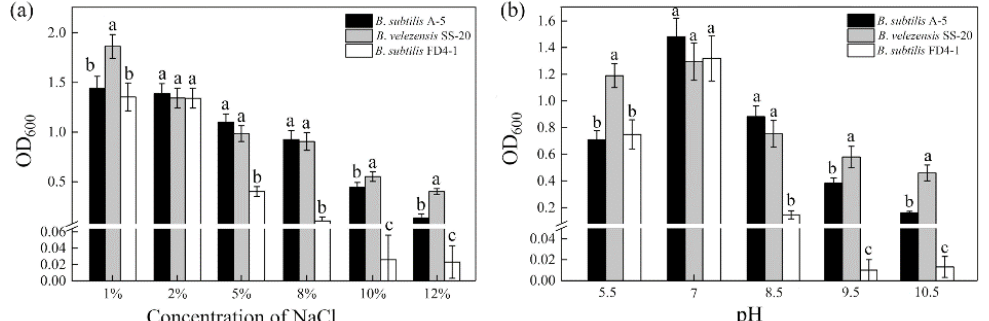
Figure 3. Salinity ( a ) and alkalinity ( b ) tolerance of B. subtilis A-5. The lowercase letters indicate significant differences among different strains ( p < 0.05).